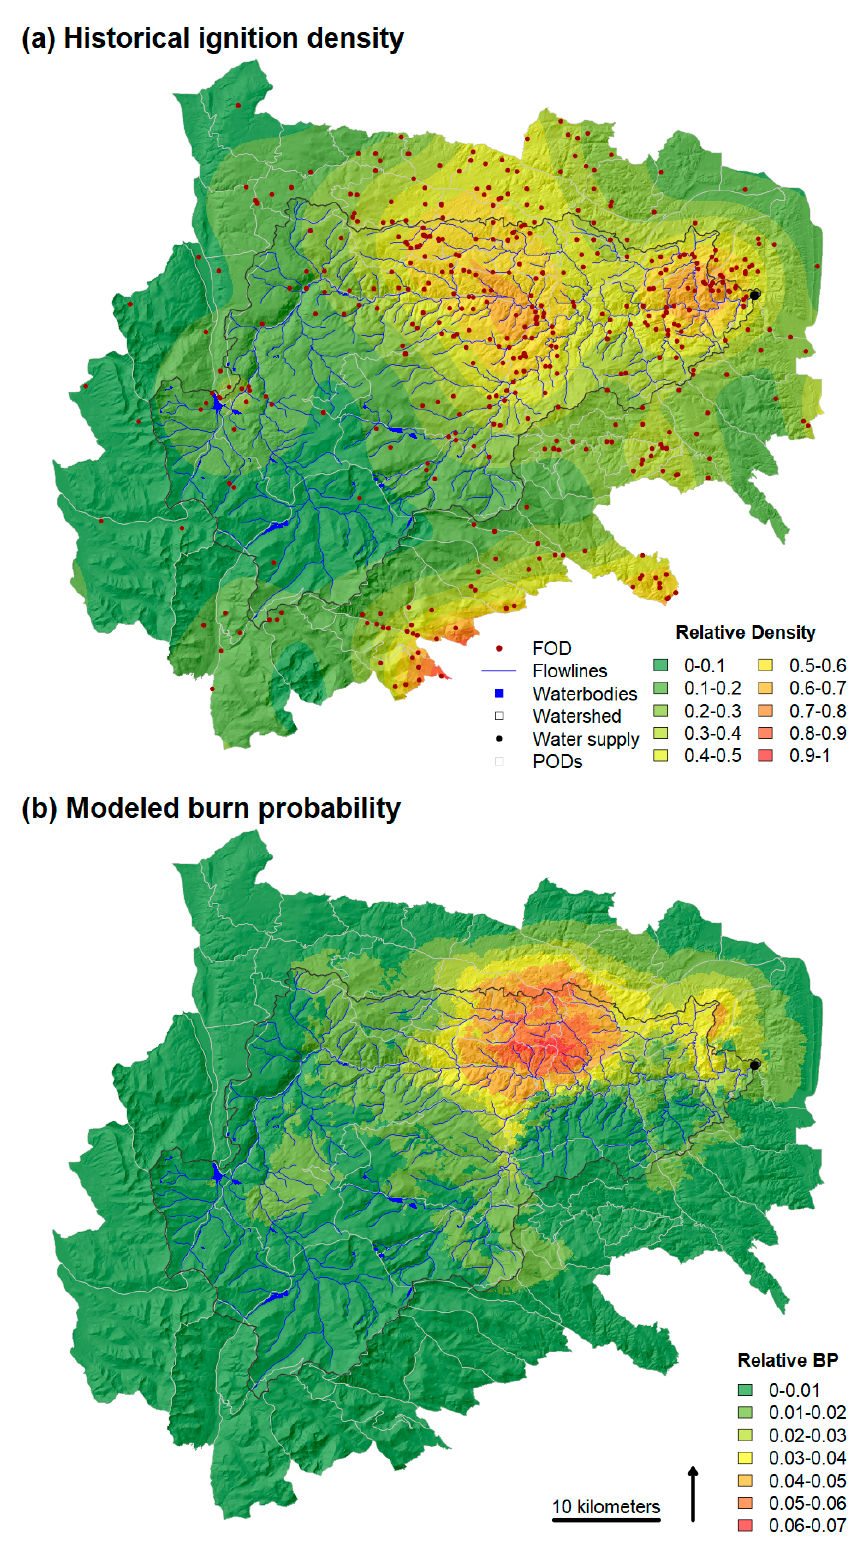
Figure 3. ( a ) Fire Occurrence Database (FOD) records of historical ignitions and interpolated surface of relative ignition density used in the RANDIG simulations. ( b ) Burn probability from the simulated fires that intercept the study watershed.